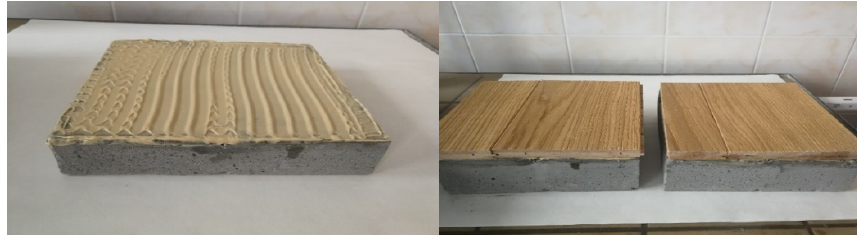
Figure 4. Picture of a cross-section of the sample type D (dry indoor conditions). Figure 5. Picture of a cross-section of the sample type W (wet indoor conditions).